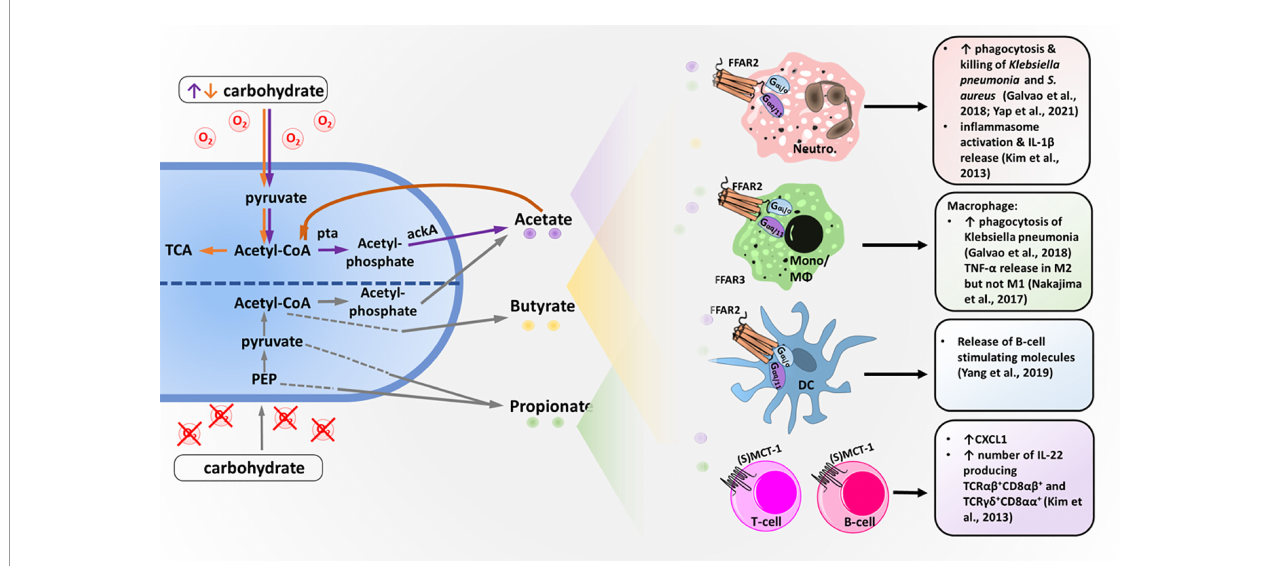
FIGURE 1 | Bacterial short-chain fatty acid (SCFA) production and SCFA effects on different immune cells. Under anaerobic conditions, bacteria metabolize carbohydrates into SCFA acetate, propionate and butyrate using different pathways. Acetate and butyrate are primarily produced via acetyl-CoA, whereas propionate is made from pyruvate or phosphoenolpyruvat (PEP) via multiple different pathways. Under aerobic conditions and excess carbohydrates (orange arrows), carbohydrates are digested into acetate via acetyl-CoA using the phosphatase/acetyl-kinase A (Pta/AckA) pathway. Acetate, butyrate and propionate are secreted into the bacterial environment and can then be detected by different immune cells. Neutrophils (Neutro.), monocytes (Mono.), macrophages (M F s) and dendritic cells (DCs) express the SCFA receptor FFAR2, which is coupled with the G-protein G-alpha i/o and G-alpha q/11. T and B cells lack FFAR2 but express the acetate transporter (sodium-) monocarboxylate transporter 1 ((S)MCT-1), which allows acetate to modulate transcription via histon deacetylase stimulation. Activation of the different immune cells by SCFAs results in the effects described on the